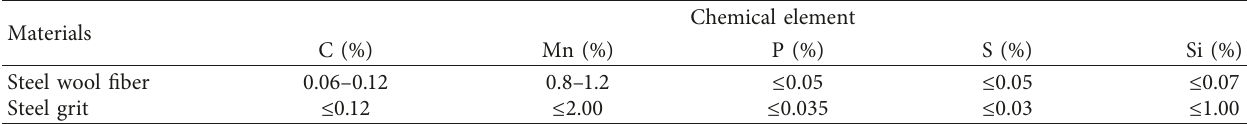
Table 2: The impurity element content of steel wool fiber and steel grit.